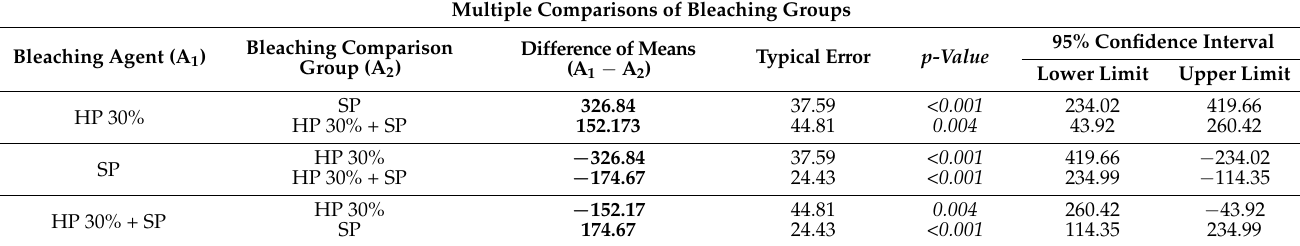
Table 2. Comparison of the results obtained between the different bleaching groups with the Games– Howell contrast test after 10